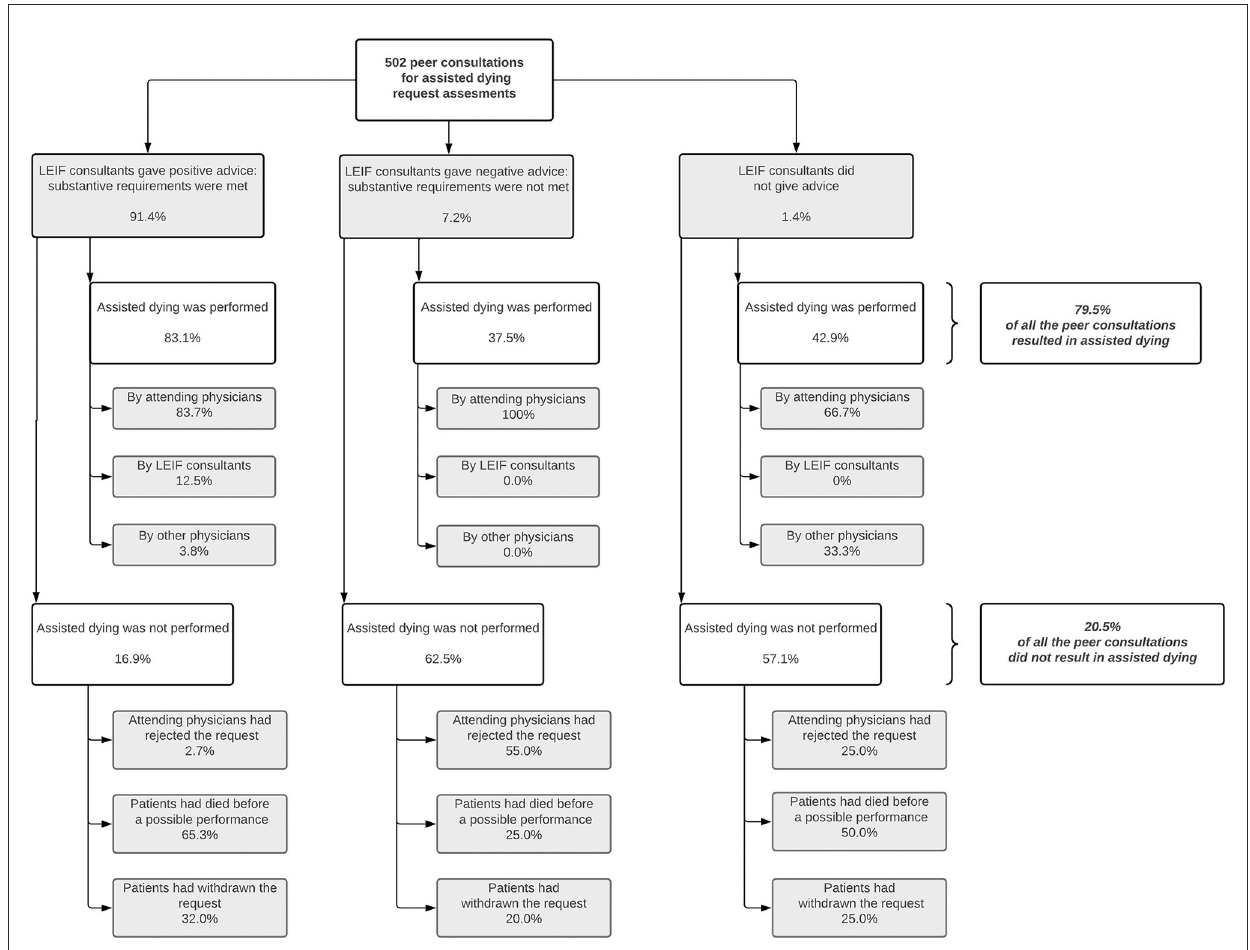
FIGURE1 Advices from life end information forum (LEIF) consultants on whether substantive requirements were met in the most recent peer consultations for an assisted dying request assessment, and the outcomes of these assisted dying requests following the consultations (within-group percentages). Missing values range from 3.0% to 3.8%. Percentages may not always add to 100% because of